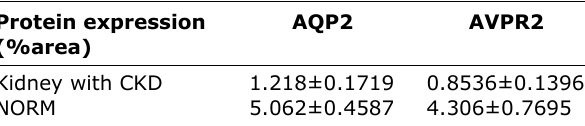
Table 1: The semi-quantitative evaluation of protein AQP2 and AVPR2 expression (percent area) as the mean±SEM on kidney with CKD and normal kidney (NORM). The Mann–Whitney U-test: Values are given as mean±SEM (p<0.001).